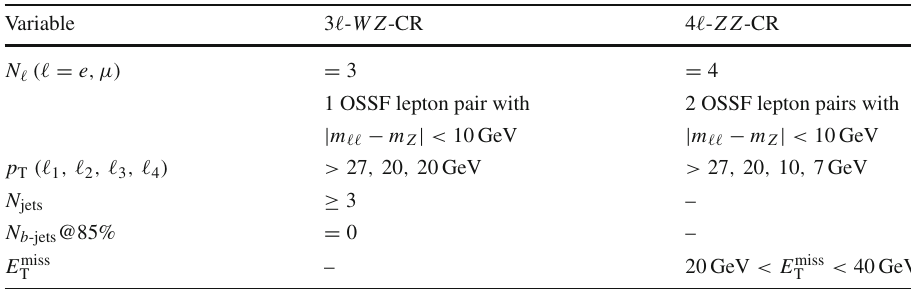
Table 3 Definitions of the control regions targeting the W Z + jets, W Z → (cid:11)(cid:11)(cid:11)ν (left) and Z Z + jets, Z Z → (cid:11)(cid:11)(cid:11)(cid:11) processes (right): the control regions are used to obtain normalisations of the light-flavour components of the W Z / Z Z + jets backgrounds from data